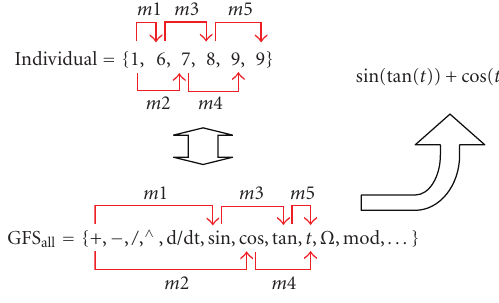
Figure 3: Main principles of